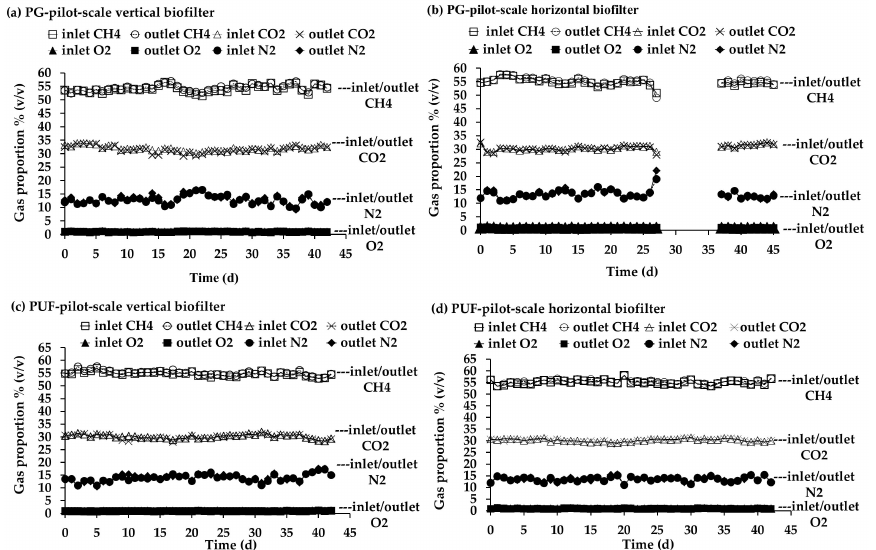
Figure 6. Biogas compositions in the pilot-scale biofilters packed with immobilized P. versutus CM1 cells on ( a ) PG vertical biofilter and ( b ) PG horizontal biofilter ( c ) PUF vertical biofilter and ( d ) PUF horizontal biofilter. The biofiltration operated at the SV of 30 and 20 h − 1 for PG and PUF,